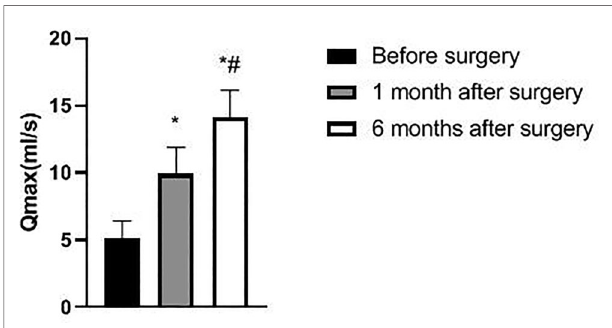
FIGURE 3 | Changes in Qmax of patients before and after